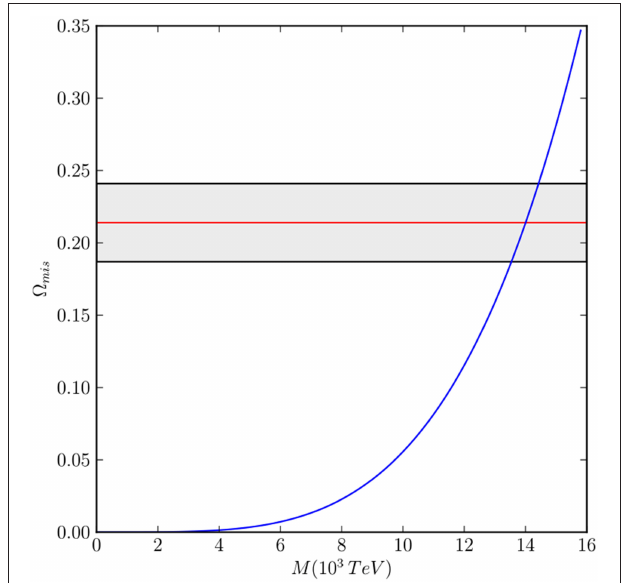
FIGURE 5 | Relic density of the axi-Higgs as a function of M . The gray bar represents the measured value of (cid:127) DM h 2